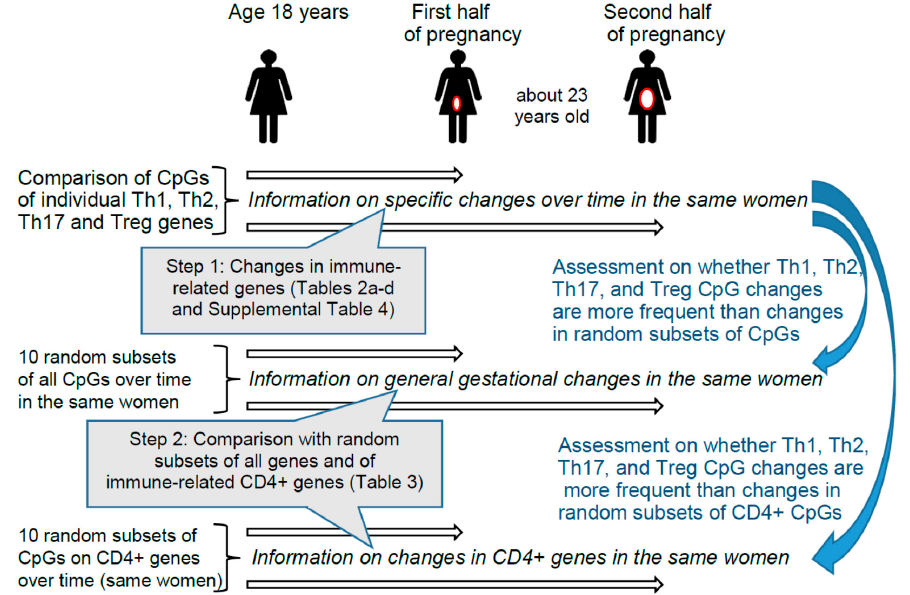
Figure 1. Design and steps of the epidemiologic analyses. Step 1 provides information on changes for 348 specific CpGs found in Th1, Th2, Th17, and Treg immune genes described in Table 1. In Step 1 we checked each CpG of different genes individually. In Step 2, we tested whether the 348 CpGs of genes involved in T cell pathways changed more frequently from prepregnancy to early or late pregnancy than randomly selected CpGs from non-T cell-pathways. The two comparison groups of CpGs included first, 10 subsets of randomly selected CpGs from all other non-T cell-pathways CpGs, and second, subsets of randomly selected CpGs from other CD4+-genes (immune-related genes) [58].